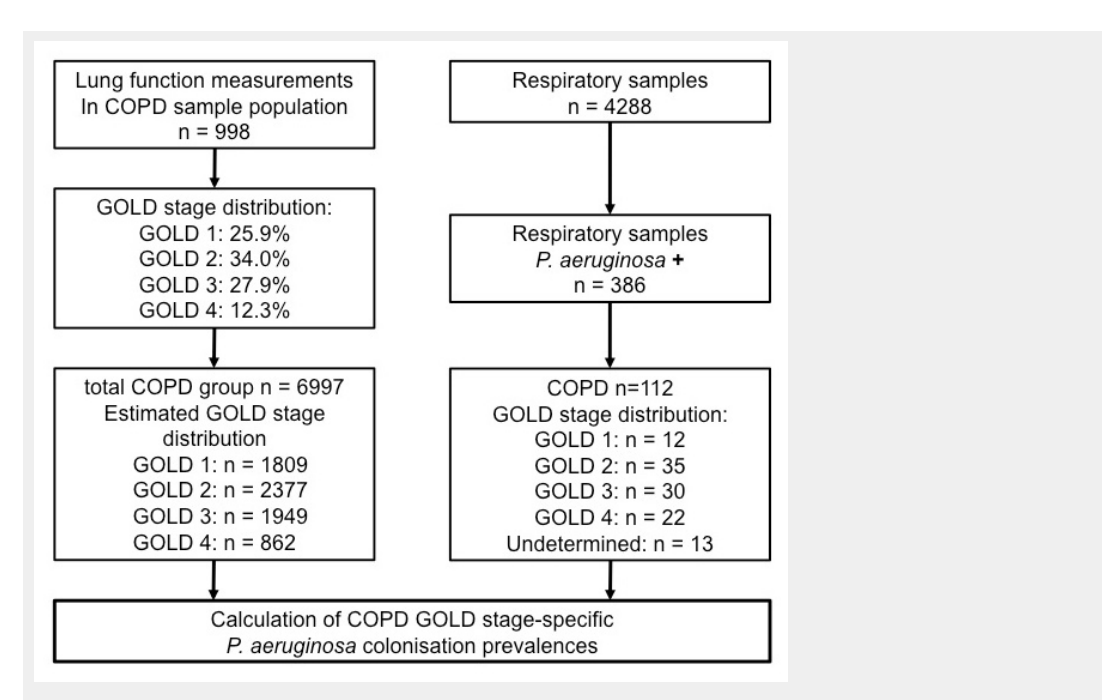
Algorithm used to perform analyses and estimations of prevalences. Patient populations, lung functions and respiratory samples were defined in the methods section. COPD severity was graded according to the GOLD classification as detailed in the methods